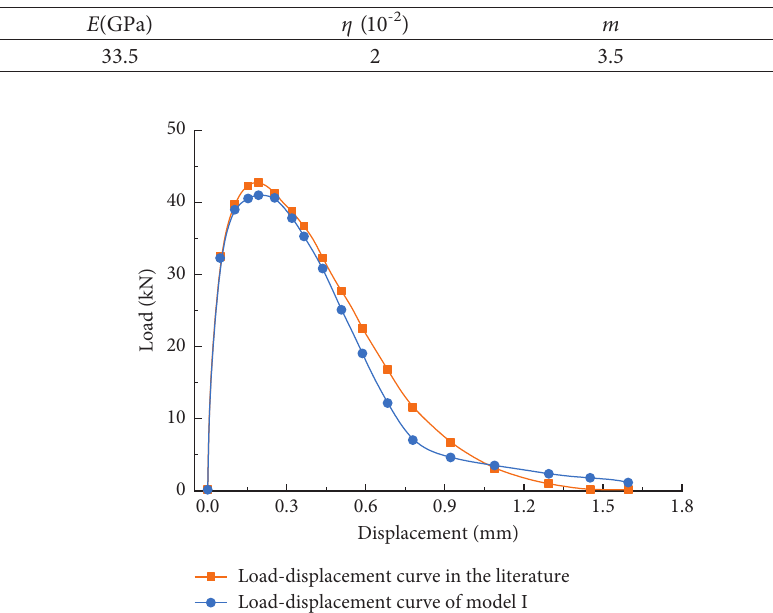
Figure 2: Comparison between numerical simulation and laboratory experiment.